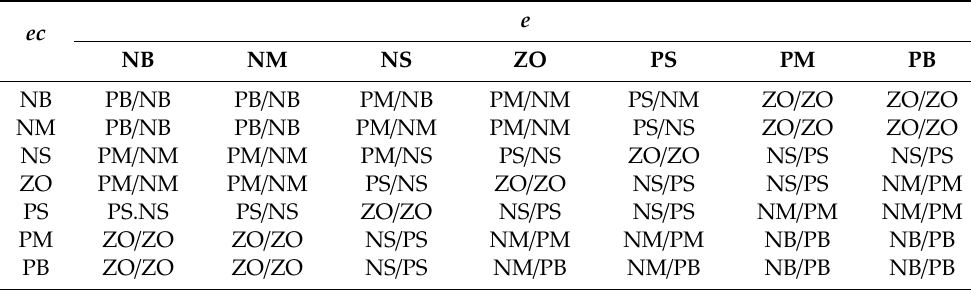
k / k . k / k . 1 2 1 2